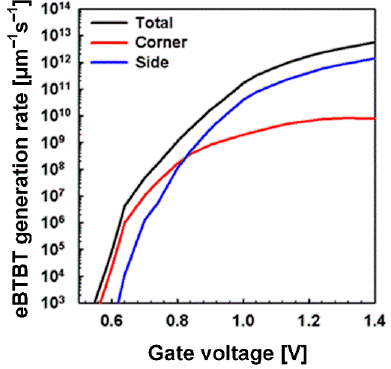
Figure 5. Electron BTBT generation rates per channel length extracted in the corner, side and total region as a function of V G .